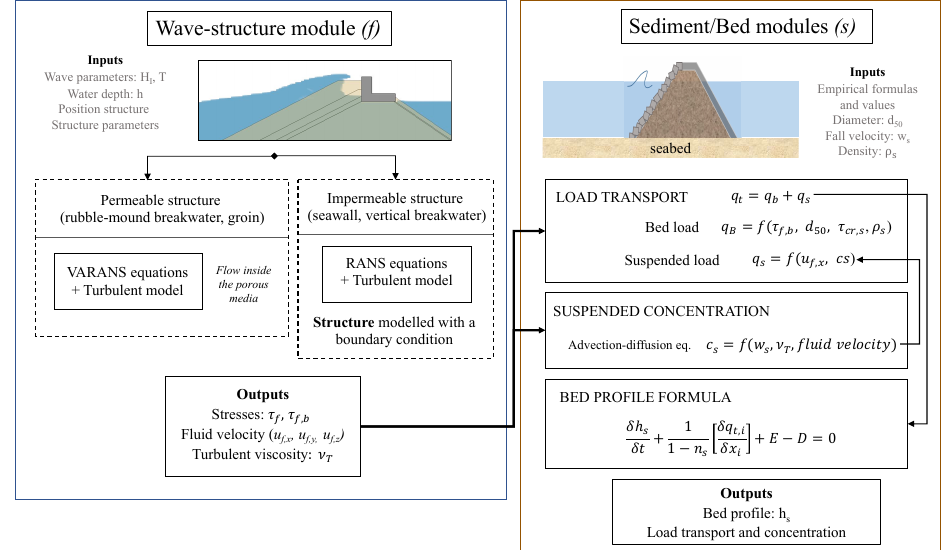
Figure 7. The simple approach for modelling the wave–structure–seabed